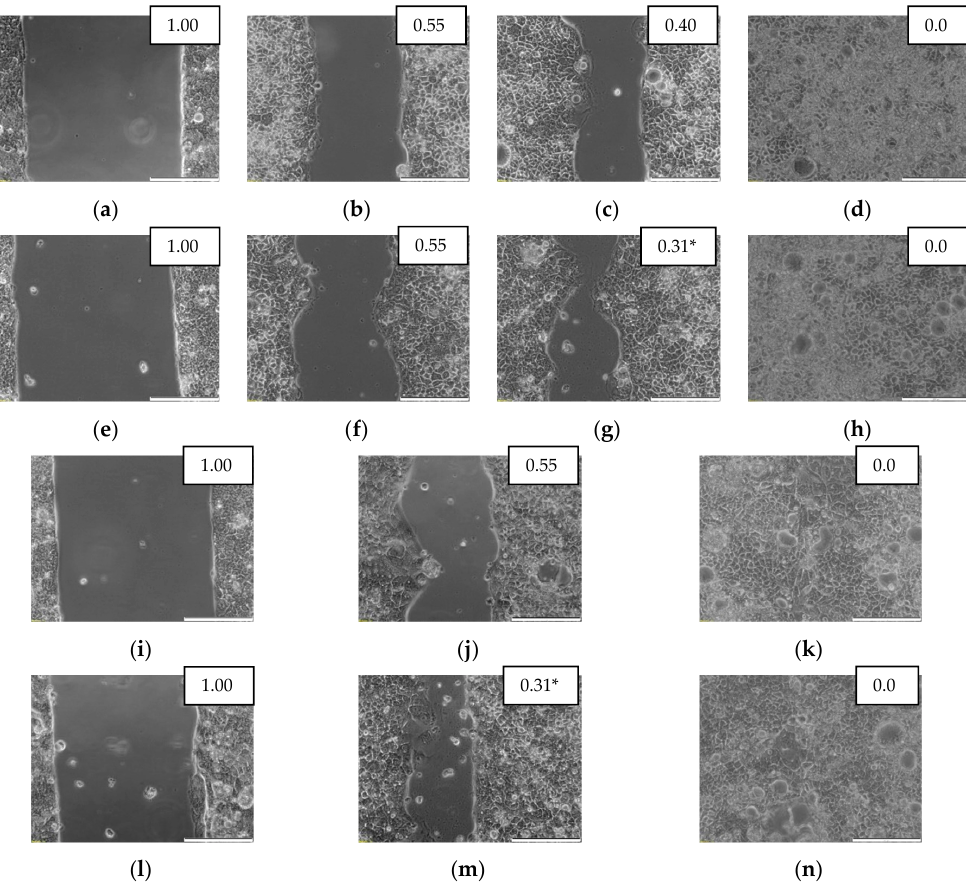
Figure 18. Impact of stimulation with 100 ng/mL of IL-4 or IL-13 on Caco-2 cells–a scratch assay (representative data): ( a ) control for IL-4 at 0 h; ( b ) control for IL-4 at 24 h; ( c ) control for IL-4 at 48 h; ( d ) control for IL-4 at 72 h; ( e ) stimulated with IL-4 at 0 h; ( f ) stimulated with IL-4 at 24 h; ( g ) stimulated with IL-4 at 48 h; ( h ) stimulated with IL-4 at 72 h; ( i ) control for IL-13 at 0 h; ( j ) control for IL-13 at 24 h; ( k ) control for IL-13 at 48 h; ( l ) stimulated with IL-13 at 0 h; ( m ) stimulated with IL-13 at 24 h; ( n ) stimulated with IL-13 at 48 h. Scale bars (200 µm) are indicated in lower right corner of each photograph. Numeric data in the upper right corner of each photograph indicate a ratio of gap (scratch) area at given time point to gap area at time 0. The rates in interleukin-stimulated cells significantly ( p < 0.01) different from their unstimulated counterparts are marked with asterisks (*). Gene Expression